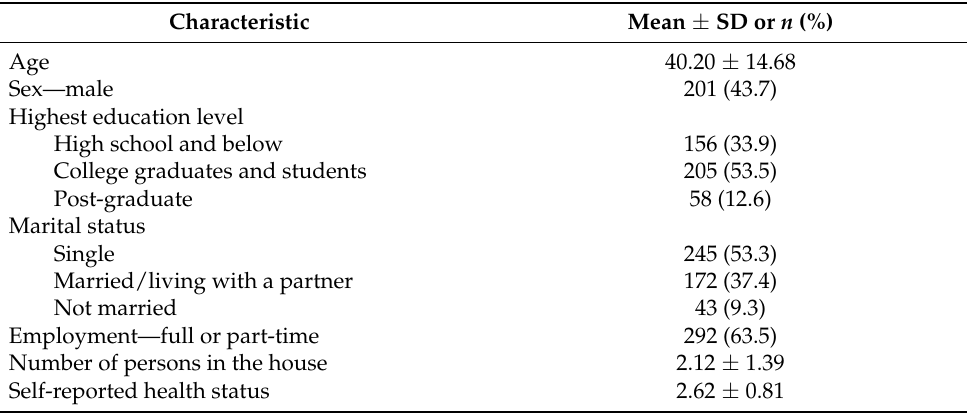
Table 1. Descriptive characteristics of the sample ( n =